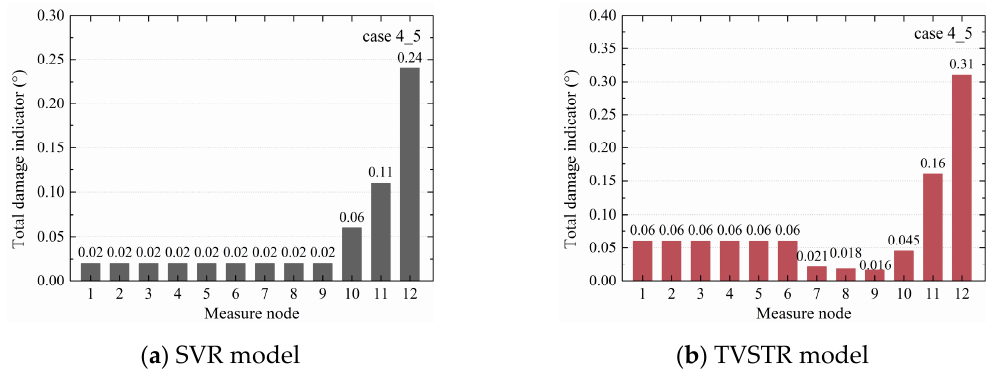
Figure 11. Total damage indicators of case 4_5 from the SVR and TVSTR models.